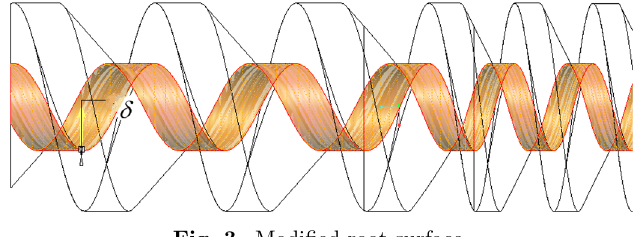
Fig. 3. Modi fi ed root surface.